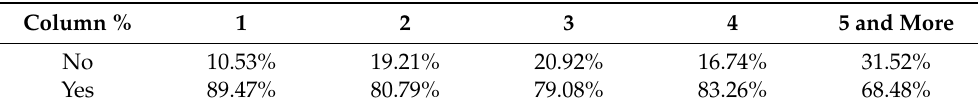
Table 7. Columnar relative frequencies (variables online organic food purchases and number of persons in the household).